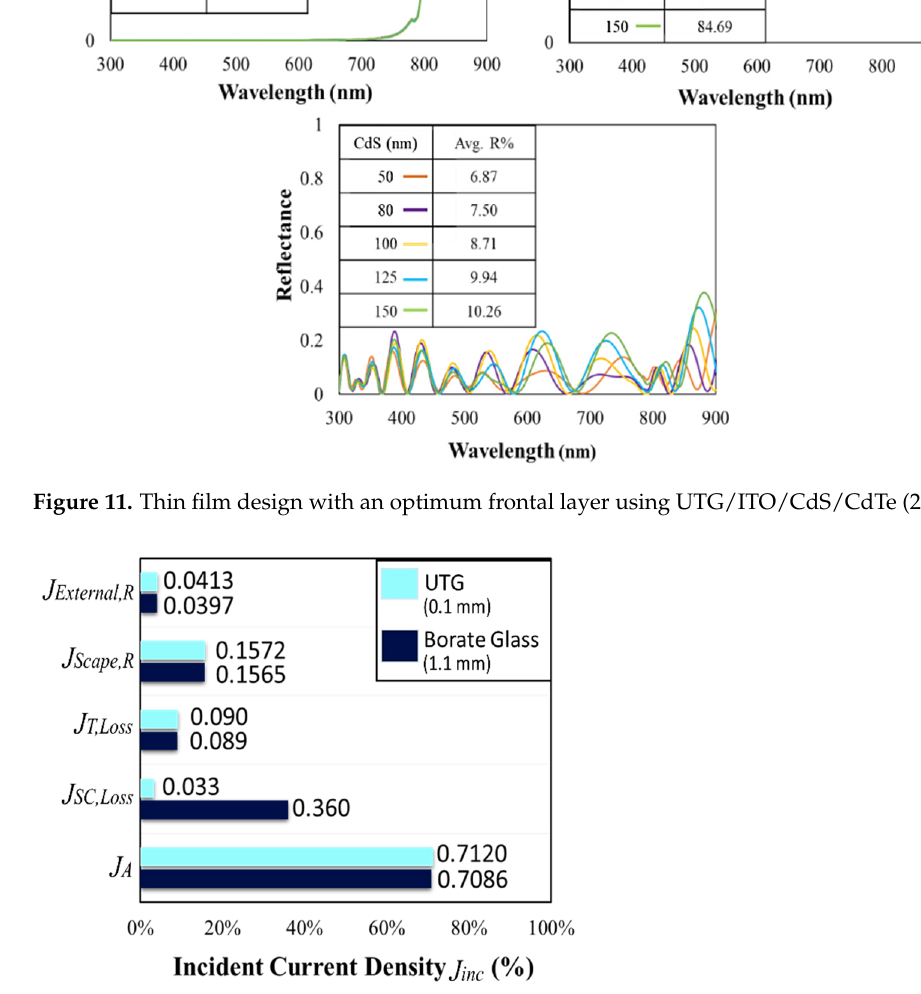
Figure 12. The effect of substrate material/thickness on overall thin-film efficiency.